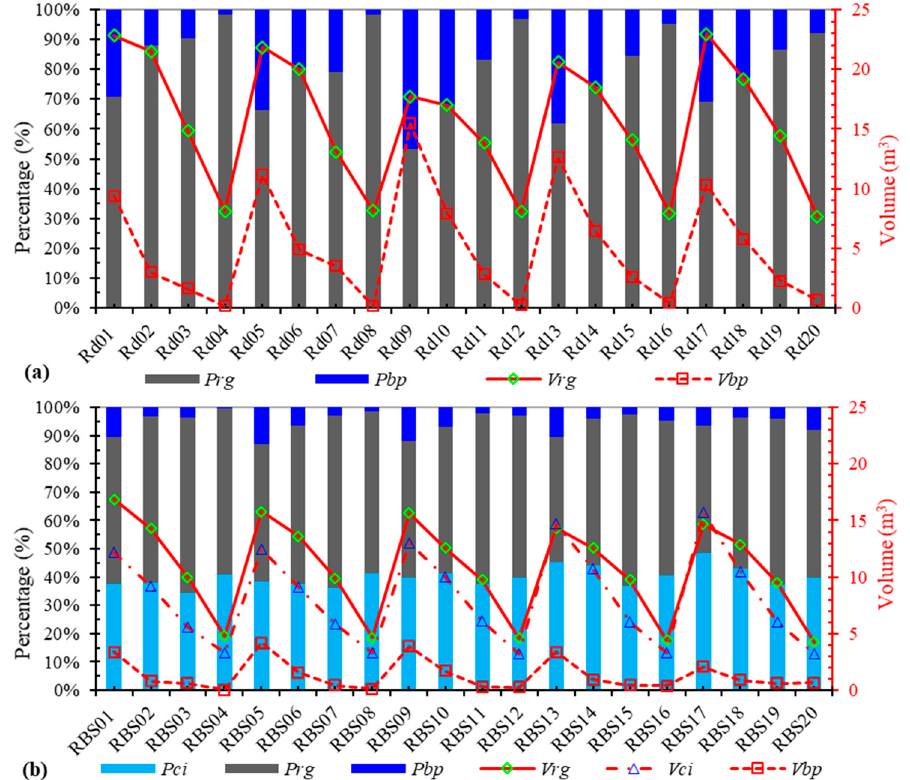
Figure 7. Runoff volumes and corresponding percentages captured by the road grate inlet ( V rg and P rg ), bypassed downstream ( V bp and P bp ) for ( a ) 20 road-only (Rd01–Rd20) and ( b ) 20 RBS modeling cases, and ( b ) intercepted by the curb inlet ( V ci and P ci ) for RBS modeling cases. Percentages are shown as a 100% stacked column diagram using a major y -axis and volumes (m 3 ) are shown as lines with symbols using a secondary y -axis.